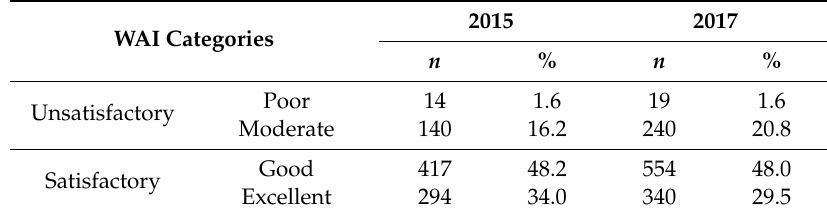
Table 7. Distribution of the Work Ability Index (WAI) categories among study participants in 2015 and